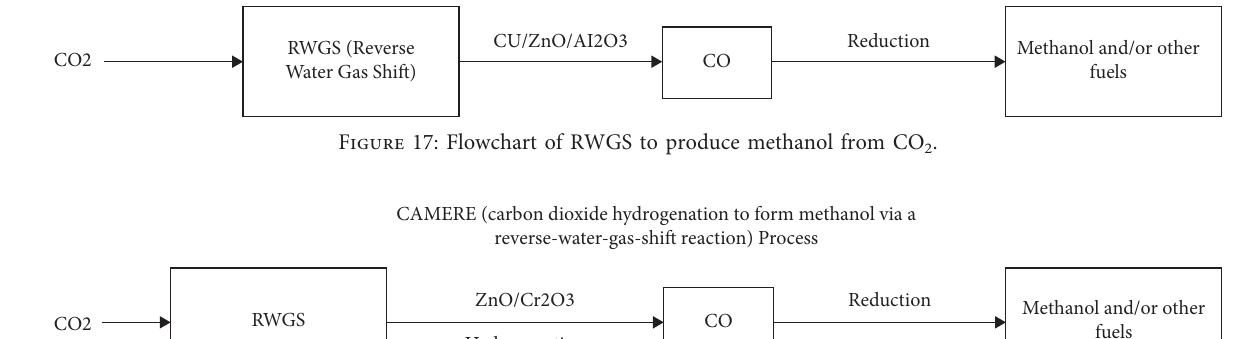
Figure 18: CAMERE process for producing